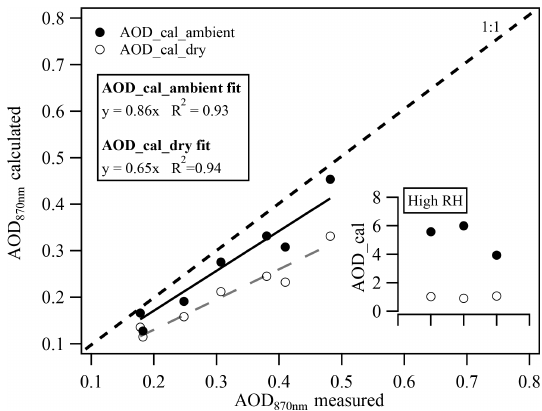
Figure 7. Comparison of in situ measured dry AOD and ambient AOD at λ = 870nm with the AERONET